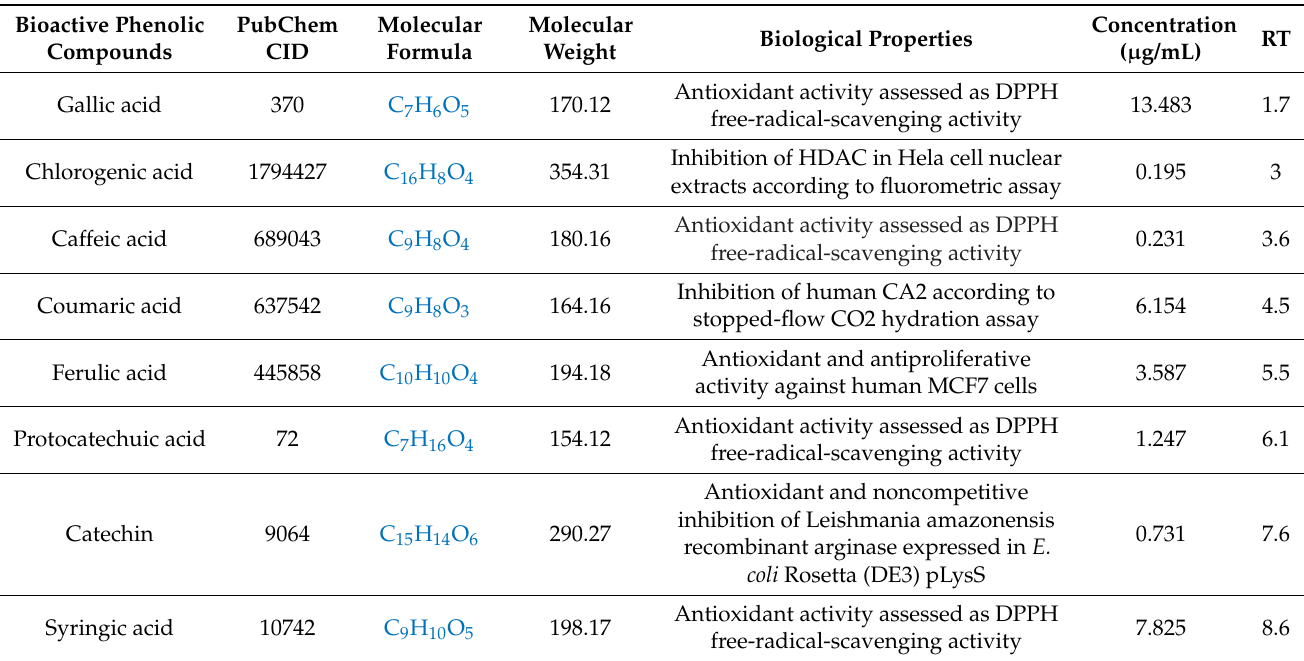
Table 2. HPLC Chromatogram of bioactive compounds (Rt = 10 min) of CHCl 3 /MeOH (2:1 v / v ) sample extract of SRLe (dried leaves to solvent, w / v ), along with the molecular formula, molecular weight, and biological